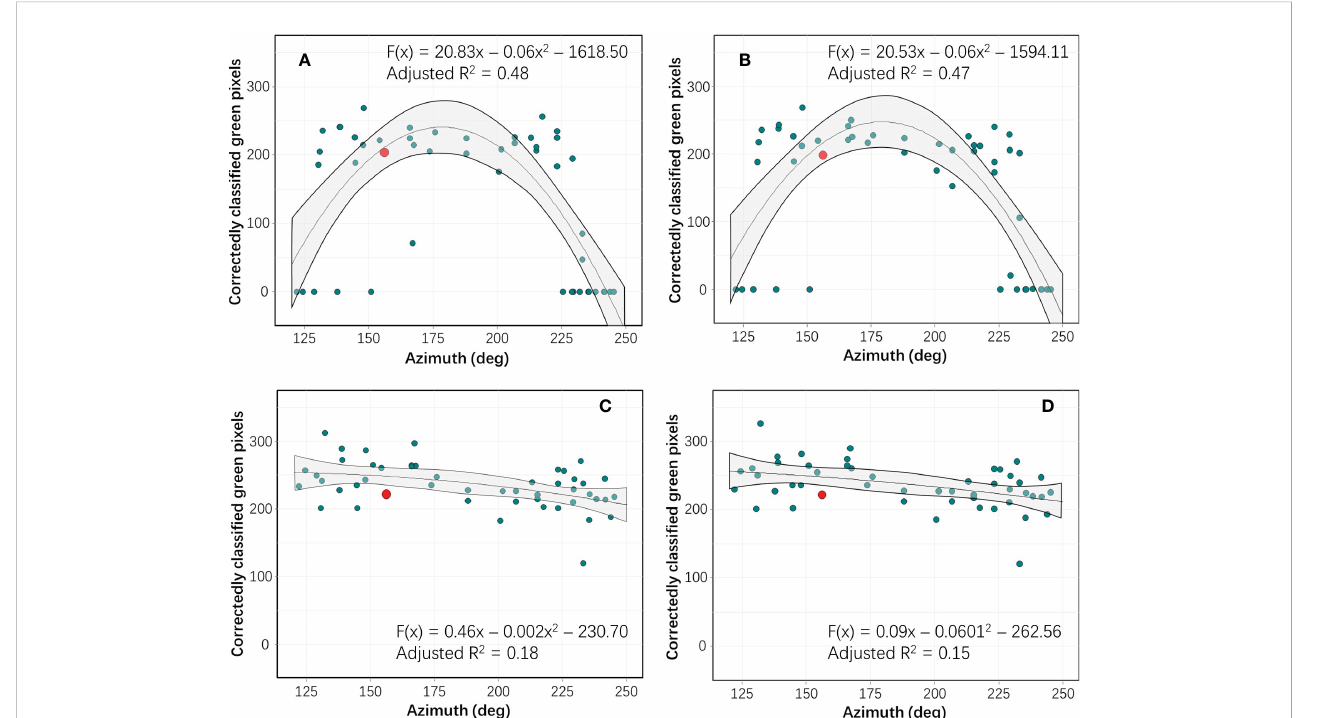
FIGURE 5 Based on remote sensing data acquired from green color panel (considered representative for all seven color panels), numbers of correctly classi fi ed pixels are plotted as a function of azimuth (deg) for each of the four levels of spectral calibration (red dots denote time point of data used to generate classi fi cation function): 1) no spectral calibration (radiance data) (A) , 2) spectral calibration based on white calibration boards (empirical line method, ELM calibration) (B) , 3) spectral calibration with irradiance data acquired with a drone-mounted down-welling sensor (ARTM) (C) , and 4) modeled sun parameters and weather variables in combination with irradiance data from drone-mounted down-welling sensor (ARTM+) (D) . In each graph, hyperspectral remote sensing data acquired during one fl ight mission (Day 2, 12:12) are presented as a white dot, as this was used to training data for the classi fi cation function applied to data from all 52 fl ight missions. A second order polynomial regression fi t was deployed to each data set, and grey areas denote 95% con fi dence intervals.